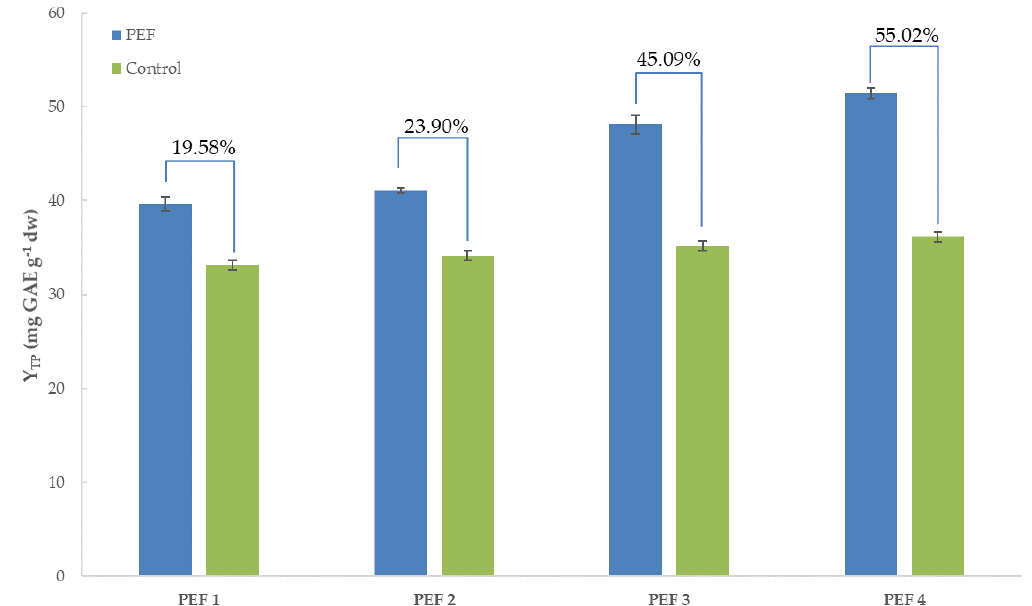
Figure 2. Total phenolics, Y TP , for Calendula officinalis flowers PEF samples, in different PEF electric field intensities, compared to control sample.